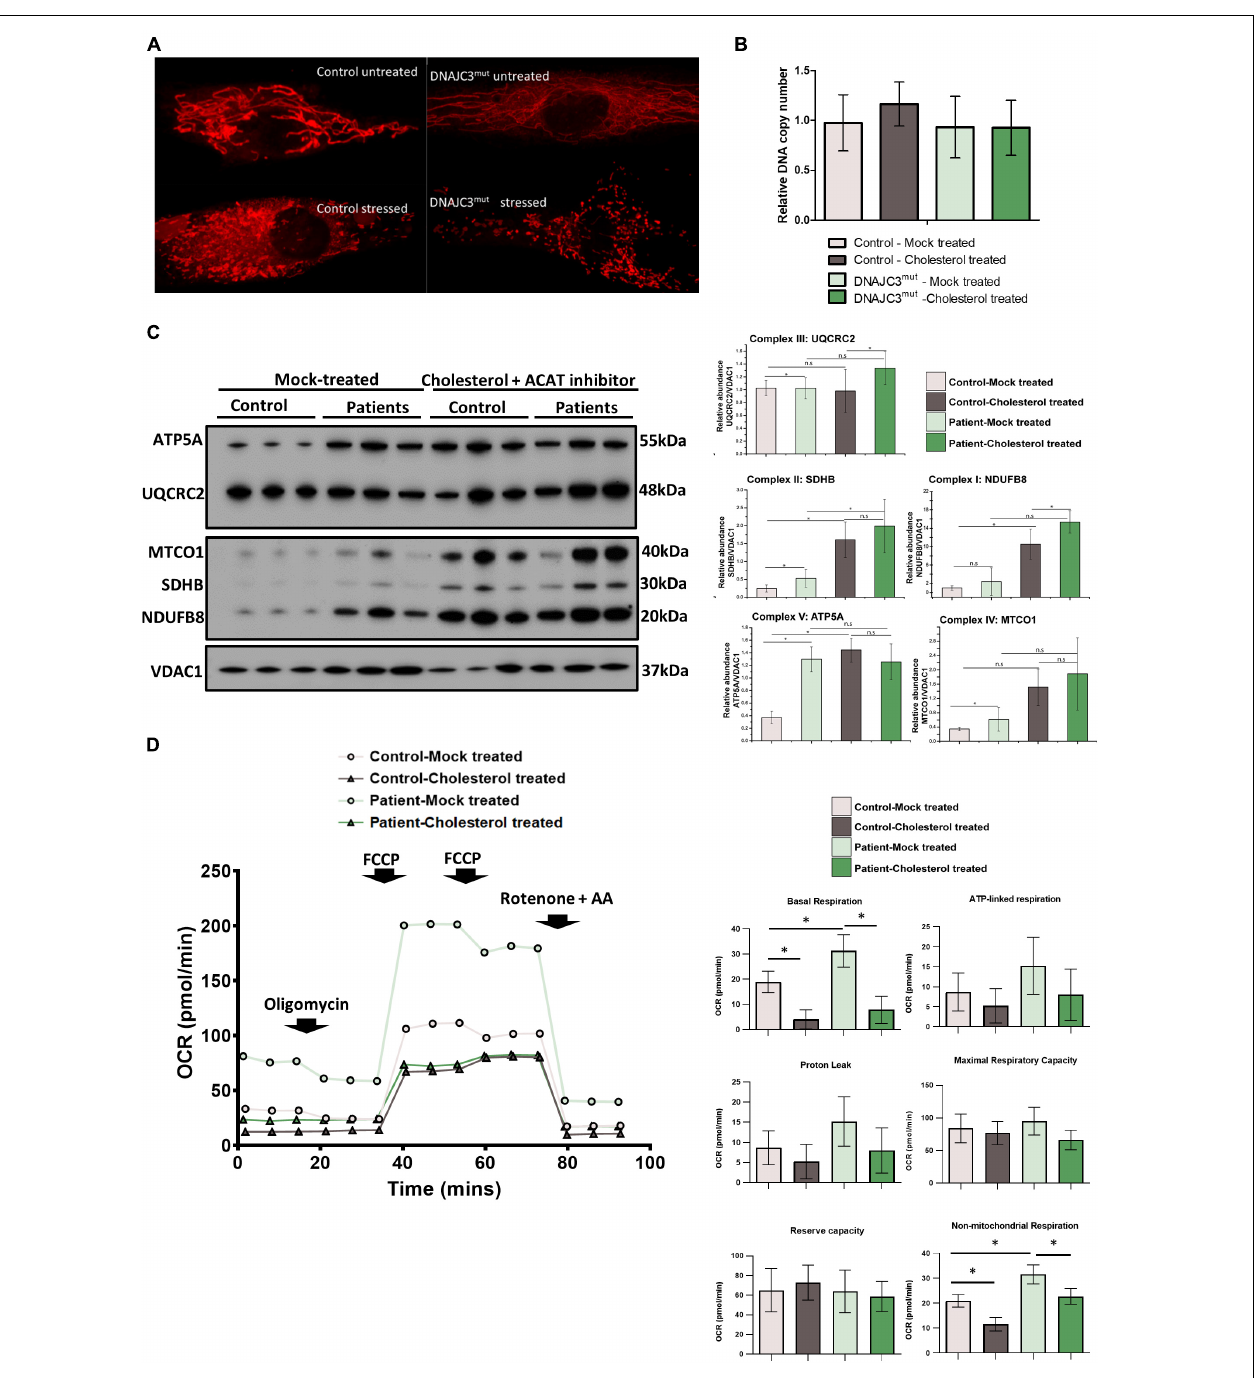
FIGURE 4 | Study of mitochondrial integrity in DNAJC3 pathophysiology. (A) Mitotracker staining in DNAJC3 mut and control fibroblasts revealed a more fragmented mitochondria in patient cells with reduced staining in DNAJC3 mut cells compared to controls. One representative cell is presented per condition, whereby 30 cells have been studied for each of the analyzed conditions. (B) Mean mitochondrial DNA copy number quantitative real-time PCR relative abundances (two technical and two biological replicates for each sample type, respectively) show that cholesterol overload results in a mild increase of mtDNA copy in control but not in DNAJC3 mut fibroblasts. (C) Immunoblot studies of the mitochondrial respiratory chain complexes I–V ( left panel ) revealed a significant increase of complex I and II as well as IV and V in DNAJC3 mut cells, which was more pronounced in DNAJC3 mut cells after cholesterol-treatment; ∗ t -test < 0.05. Level of the proteins representing the different complexes have been normalized to VDAC1. Densitometry analysis of the Western blotting results is represented in the right panel. (D) Mean oxygen consumption rate (OCR) of two biological replicates for each condition (each consisting of ≥ 12 technical replicates). Statistical significance indicated between treated versus non-treated DNAJC mut or control cells, and between DNAJC mut versus control cells under either treated or non-treated conditions. Student’s t -test, ∗ p < 0.05.